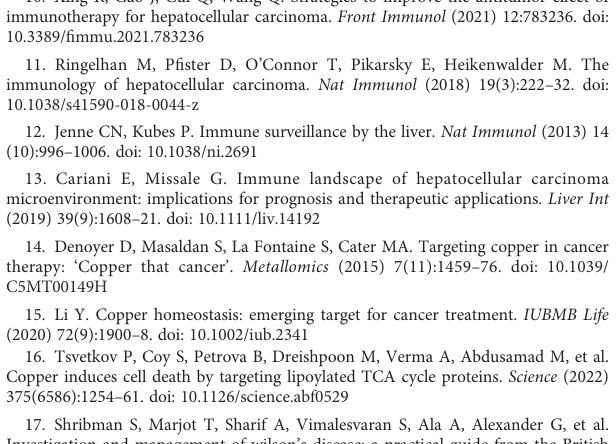
SUPPLEMENTARY FIGURE 2 Comparison of the expression levels of complement activation-related genes between the two groups in the ICGC-LIRI-JP dataset. SUPPLEMENTARY FIGURE 3 Differential pathway analysis in the TCGA-LIHC dataset grouped by risk score. (A) Top 20 KEGG differential pathways between two groups. (B) Top 20 GO- BP differential pathways between two groups. SUPPLEMENTARY FIGURE 4 Correlation analysis between cuproptosis-related genes (CRGs) and immune checkpoint genes (ICGs). (A) Correlation analysis between ATP7A and ICGs. (B) Correlation analysis between ATP13A2 and ICGs. (C) Correlation analysis between F5 and ICGs. SUPPLEMENTARY FIGURE 5 Correlation analysis between cuproptosis-related genes (CRGs) and immune cell markers. (A) Correlation analysis between PRNP and immune cell markers. (B) Correlation analysis between SNCA and immune cell markers. (C) Correlation analysis between COX17 and immune cell